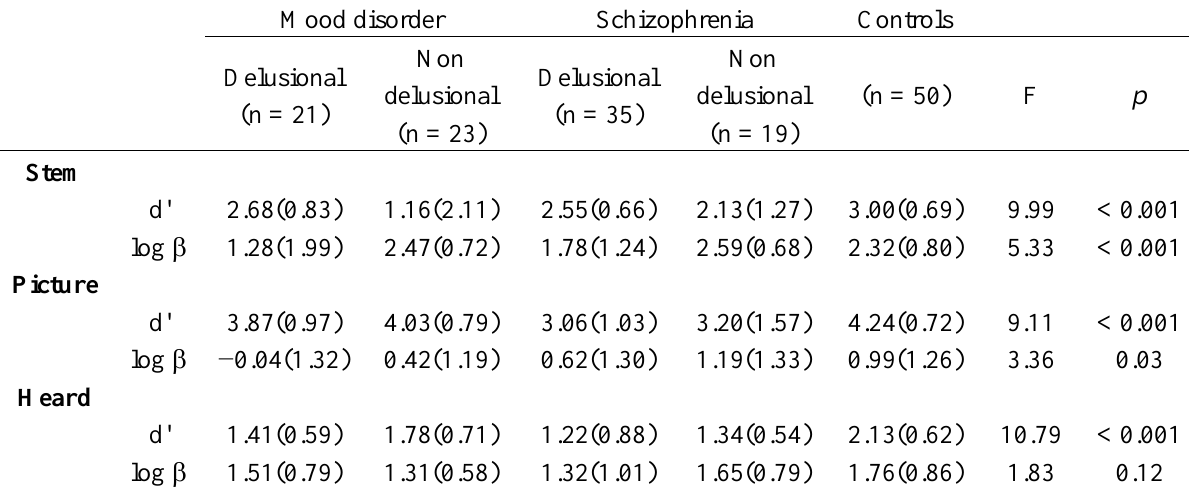
Table 2. Measures of observer sensitivity (d') and response criterion (β) for all three different